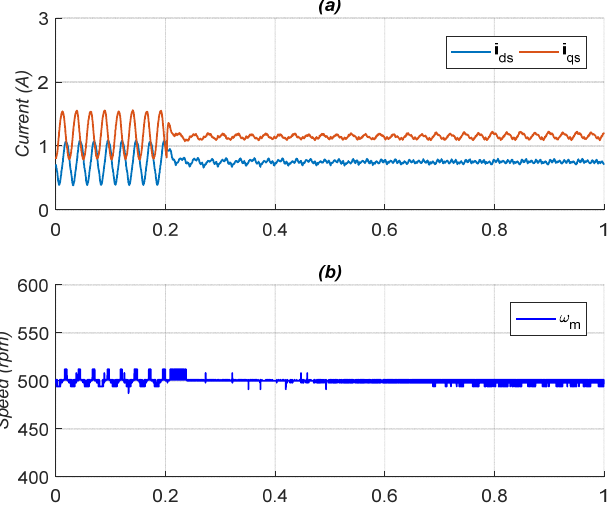
Figure 12. Postfault waveform of ( a ) the d-q current and ( b ) mechanical speed from the symmetrical six-phase IM drive before and after feedforward injection at 0.2 s.